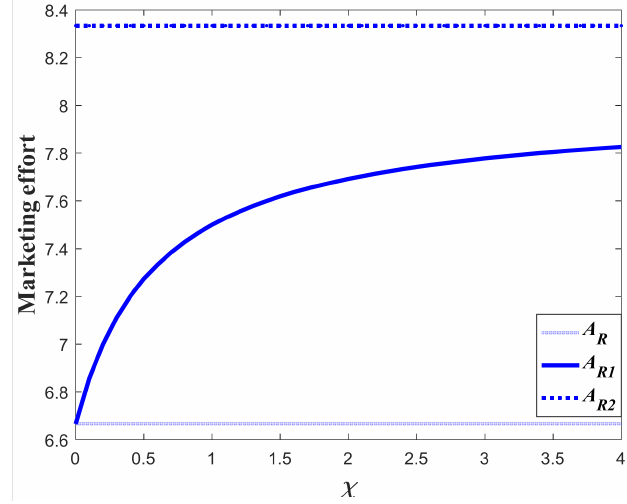
Figure 14. Marketing effort before and after the event (Scenario 2).